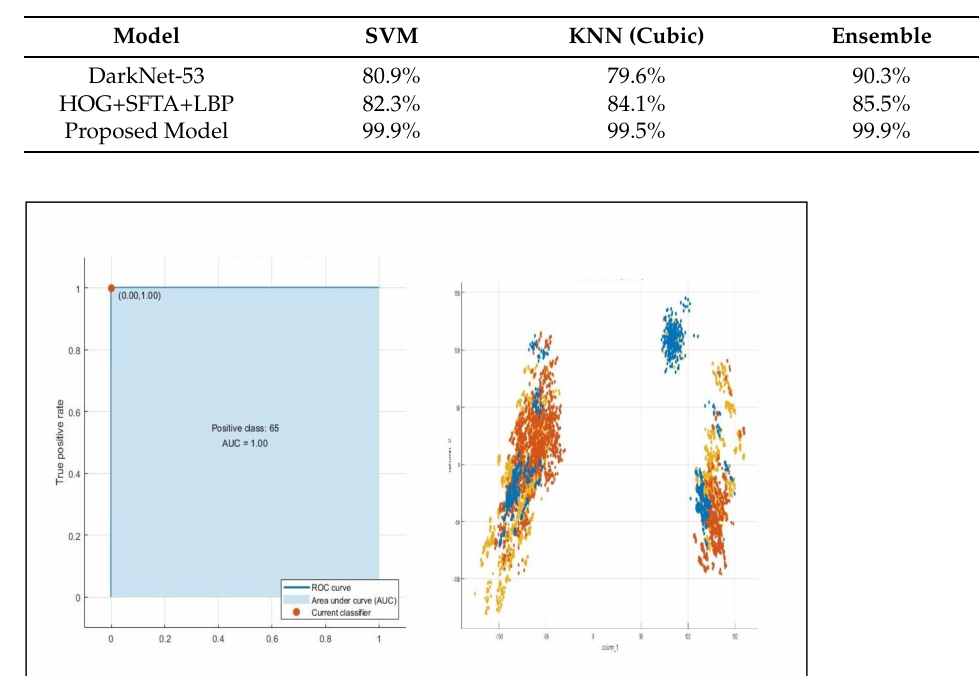
Table 8. Accuracy obtained using feature fusion approaches on different models.